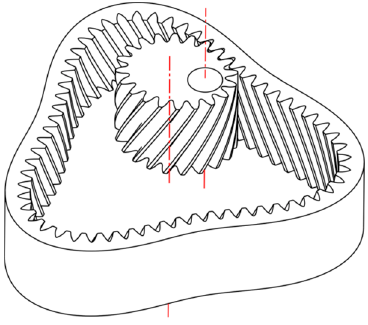
Figure 4. Example of non-circular bevel internal gears [4].